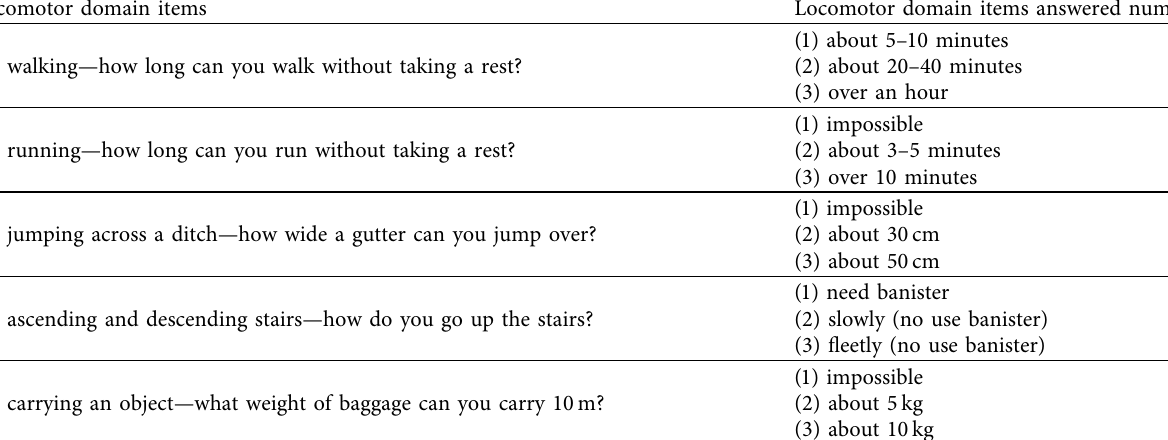
Table 1: ADL survey’s locomotor domain.